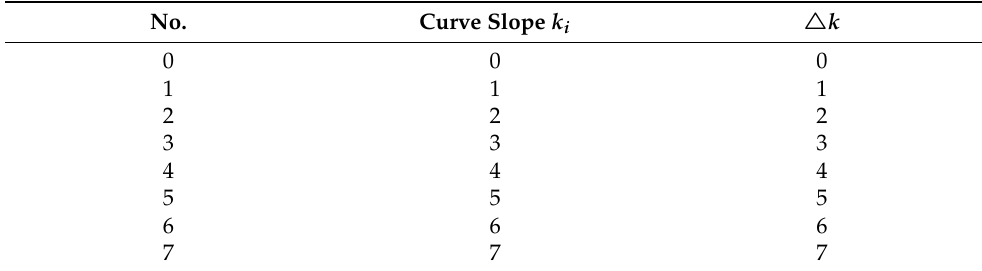
Table 2. The slope of each trend line. No.